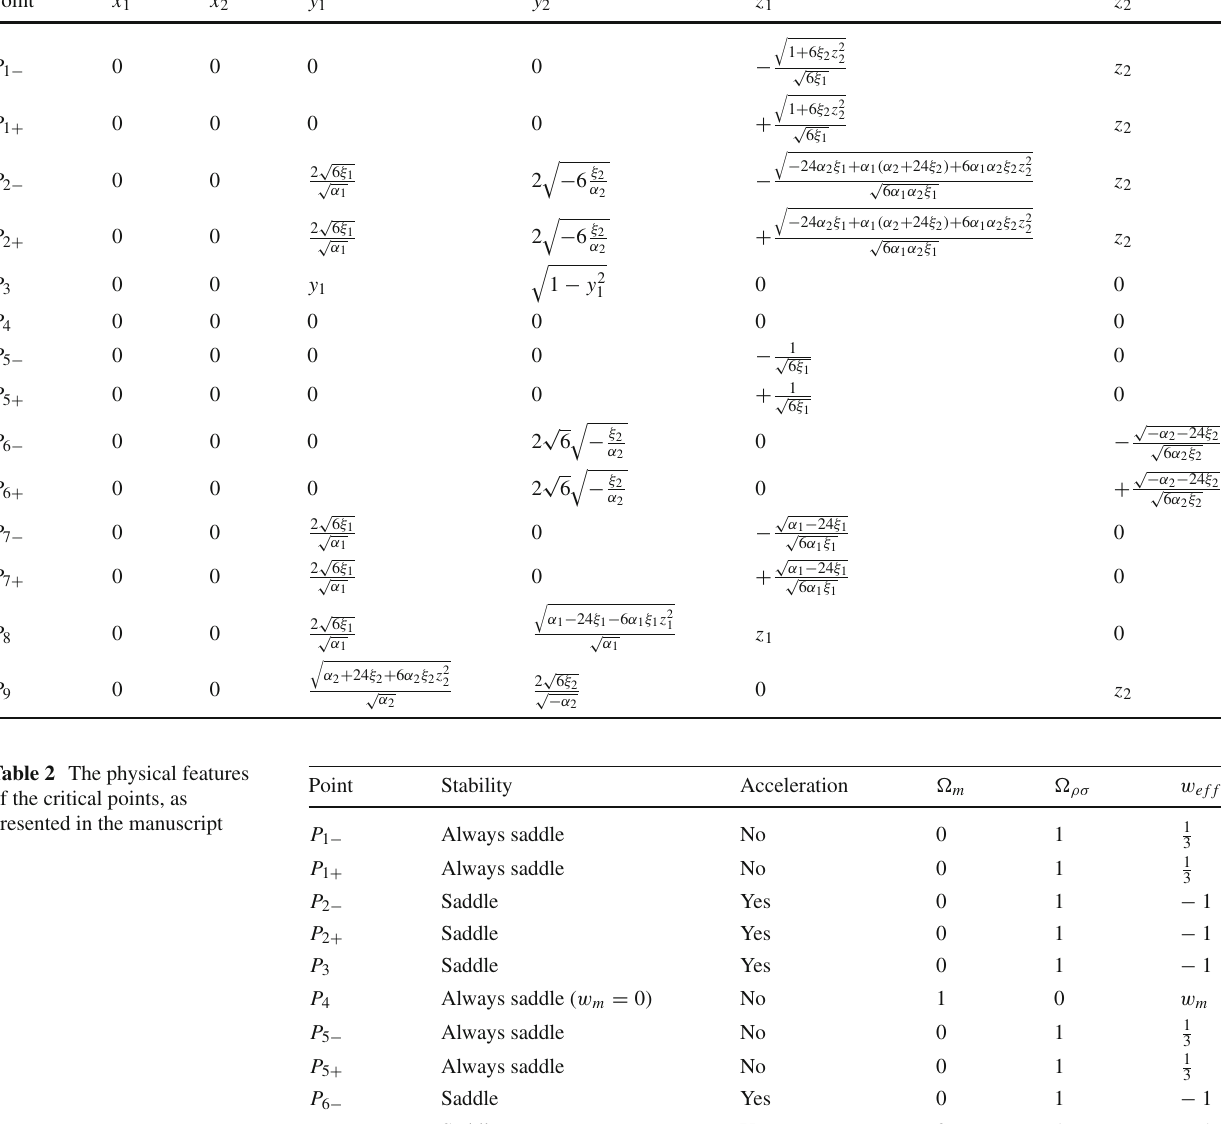
Table 1 The location of the critical points in the physical phase space Point